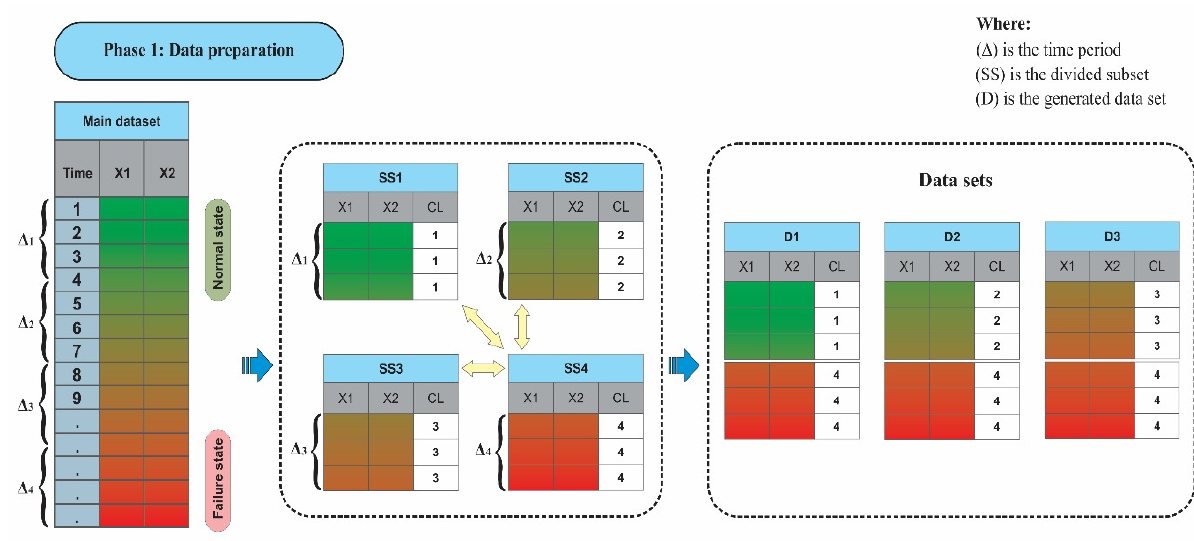
Figure 2. Data preparation phase.